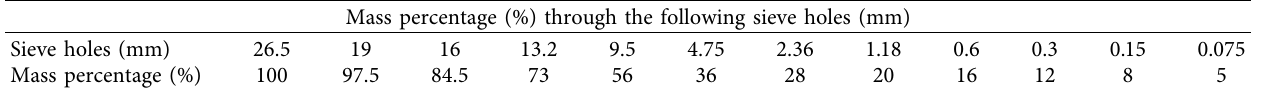
Table 2: Design results of the GAC-20C gradation.